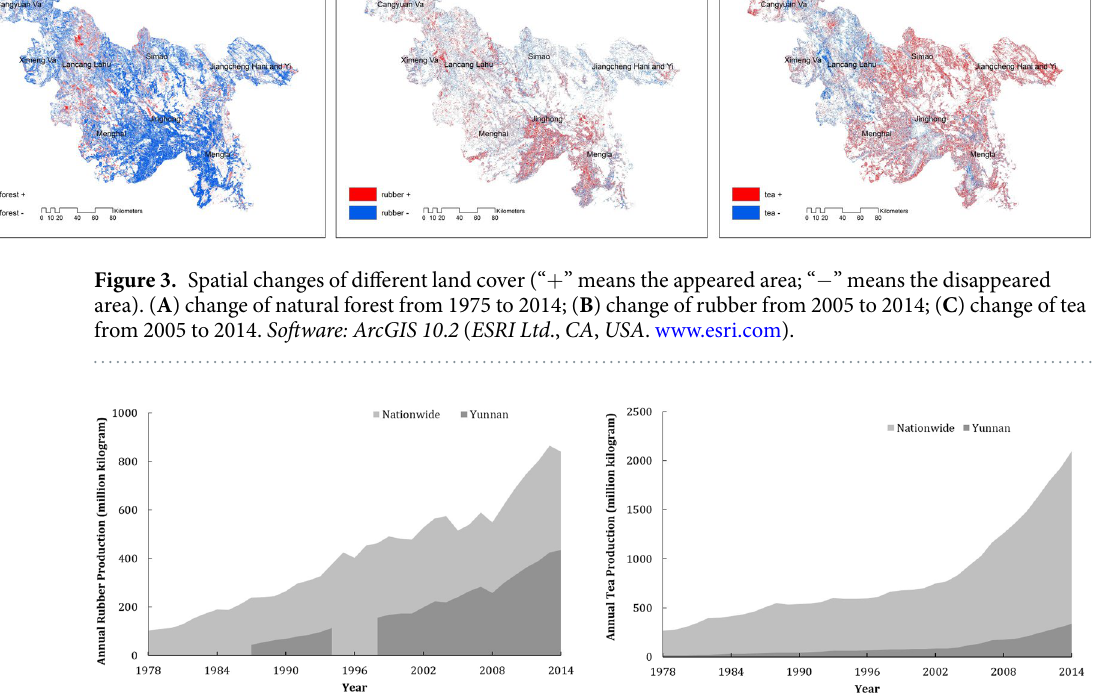
Figure 4. Annual yields for rubber and tea in Yunnan Province and nationwide during 1978 to 2014 (millon kilogram). ( A ) annual rubber yields (no data had been recorded for Yunnan from 1978–1987 and from 1995– 1997) ( B ) annual tea